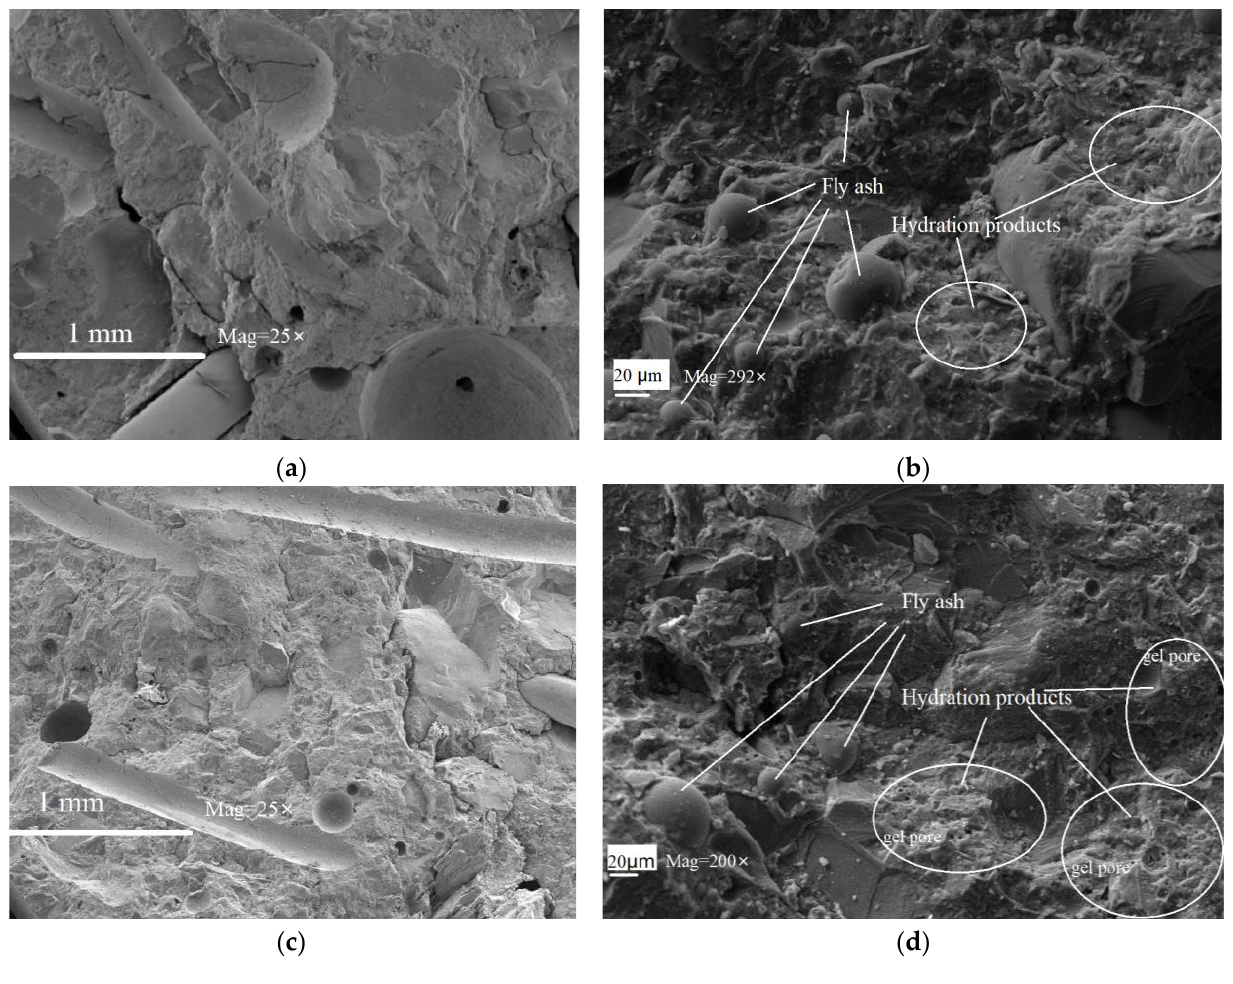
Figure 10. Comparison of SEM microscopic morphology: ( a ) SSUHPC, overall micromorphology; ( b ) SSUHPC, local microscopic morphology characteristics; ( c ) FRUHPC, overall micromorphology; ( d ) FRUHPC, local microscopic morphology characteristics.